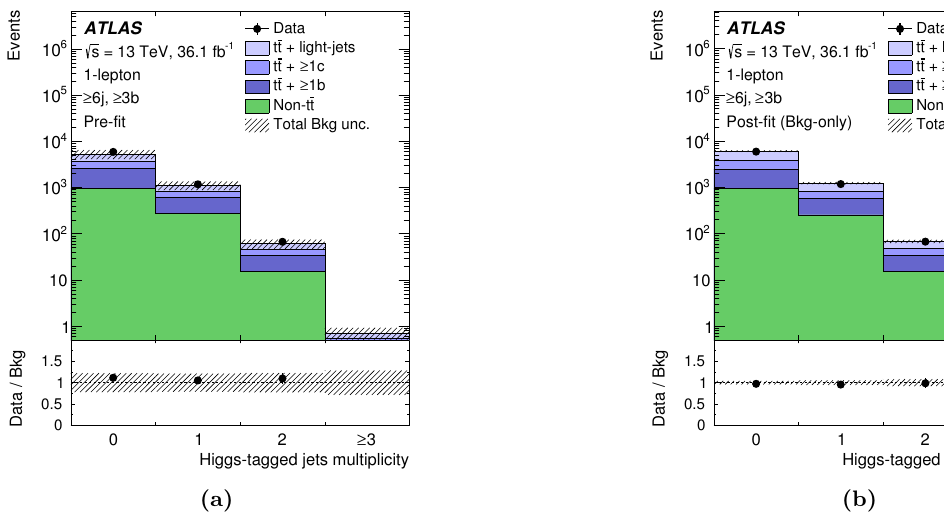
Figure 15. Comparison between the data and prediction for the Higgs-tagged jet multiplicity in the 1-lepton channel after preselection plus the requirement of before and (b) after performing the combined (cid:12)t of the m e(cid:11) spectrum to data in the 0-lepton and 1-lepton channels search regions (\Pre-(cid:12)t" and \Post-(cid:12)t", respectively) under the background-only hypothesis. The small contributions from t (cid:22) tV , t (cid:22) tH , single-top, W=Z +jets, diboson, and multijet backgrounds are combined into a single background source referred to as \Non- t (cid:22) t ". The last bin in all (cid:12)gures contains the over(cid:13)ow. The bottom panels display the ratios of data to the total background prediction (\Bkg"). The hashed area represents the total uncertainty of the background. In the case of the pre-(cid:12)t background uncertainty, the normalisation uncertainty of the t (cid:22) t + not included.